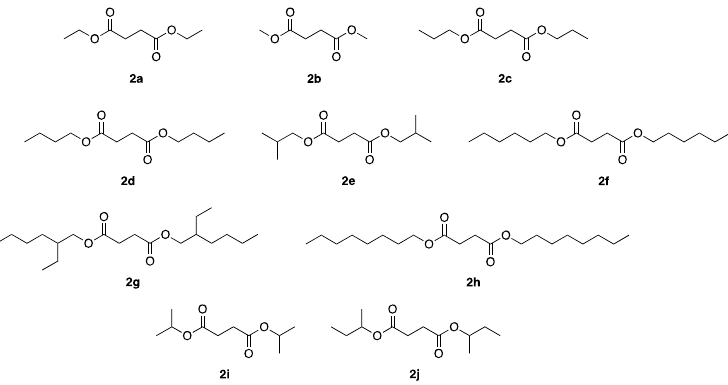
Figure 1. Selected dialkyl succinates 2a – j .